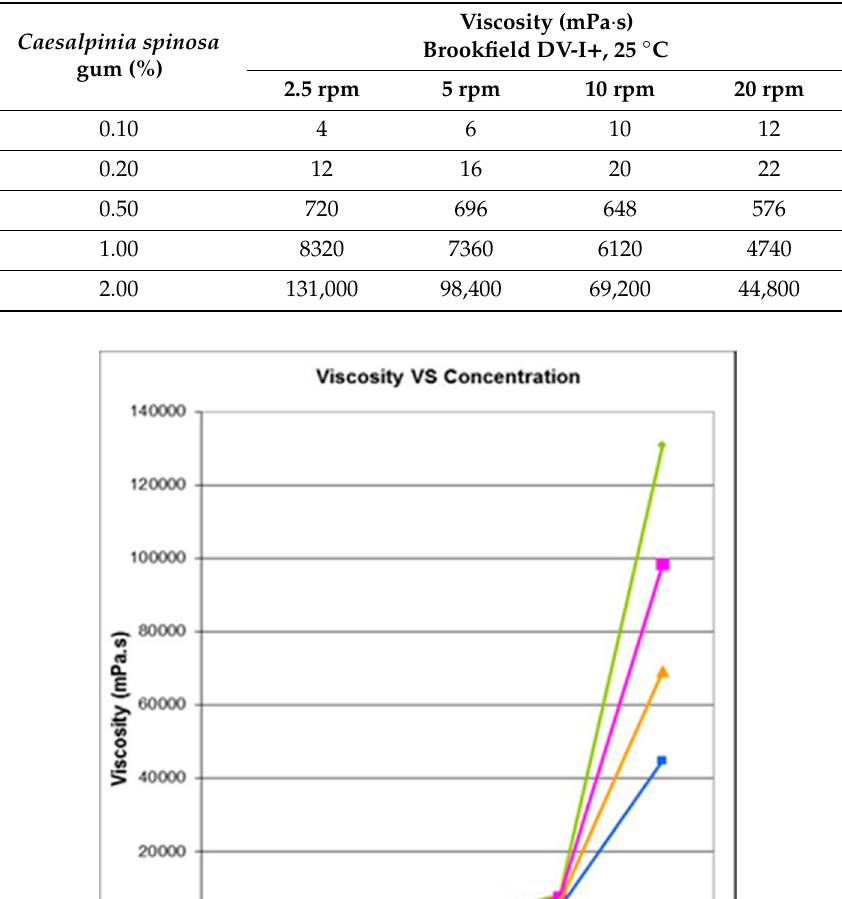
Table 1. Viscosity values for each Caesalpinia spinosa gum concentration.